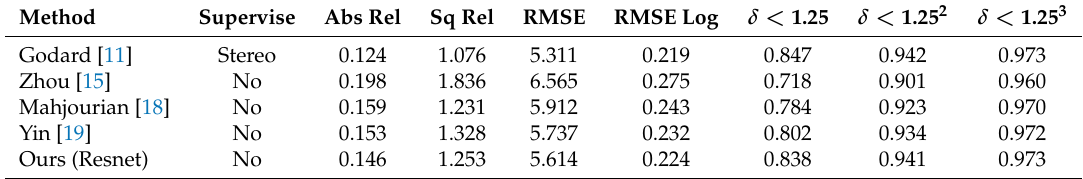
Table 3. Monocular depth results on Cityscapes and KITTI by the split of Eigen et al. [10] capped 80 m.